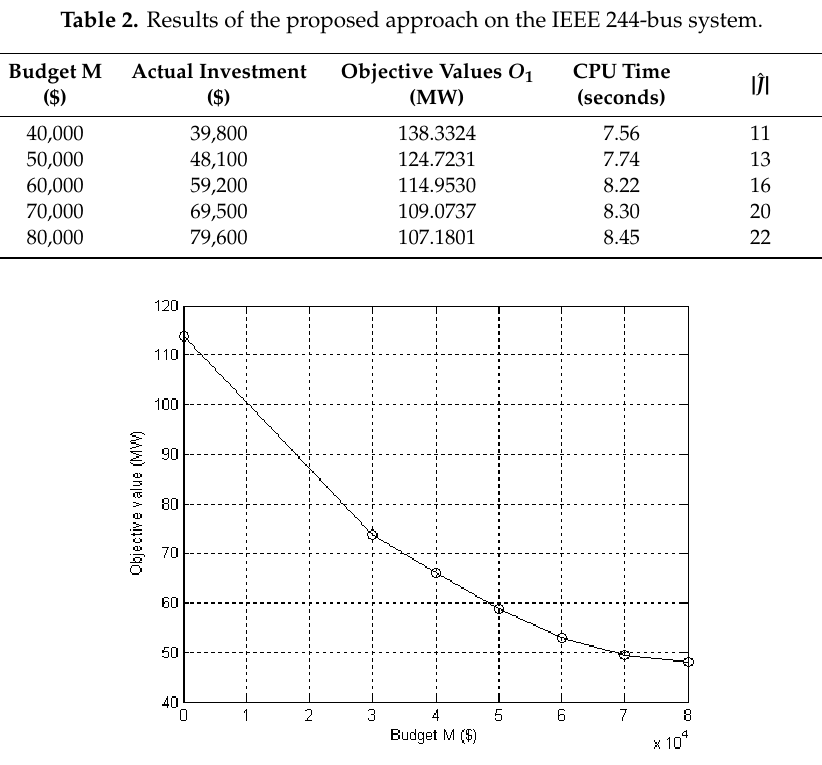
Figure 3. The objective values vs. budget on the IEEE 118-bus system for each of these investment examples.